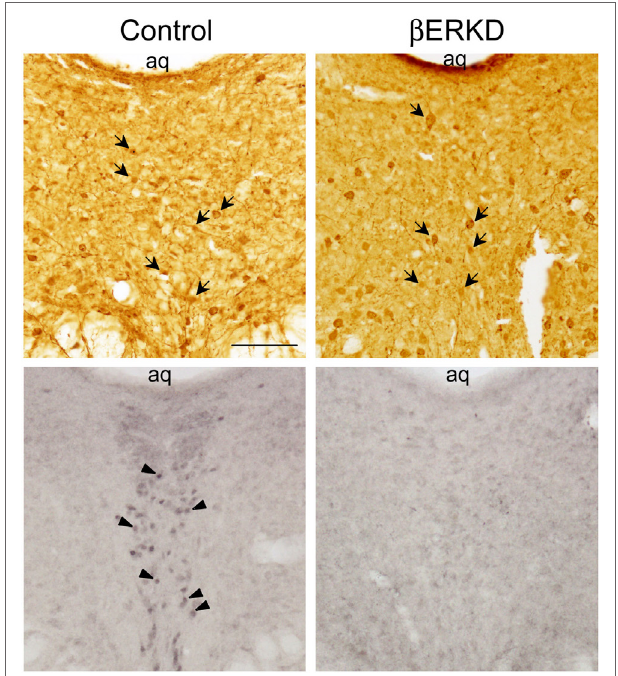
FigUre 2 | Representative photomicrographs of immunohistochemically labeled cells for green fluorescent protein (GFP) in brain sections of control and ER β knockdown ( β ERKD) groups (top panels), and those for estrogen receptor (ER) β in the adjacent sections (bottom panels). GFP and ER β immunoreactive cells were detected by the methods described in the present and previous studies (16). The scale bar in the panel represents 100 µm. Arrows in the top panels indicate GFP stained cells, and arrow heads in the bottom panel indicate ER β stained